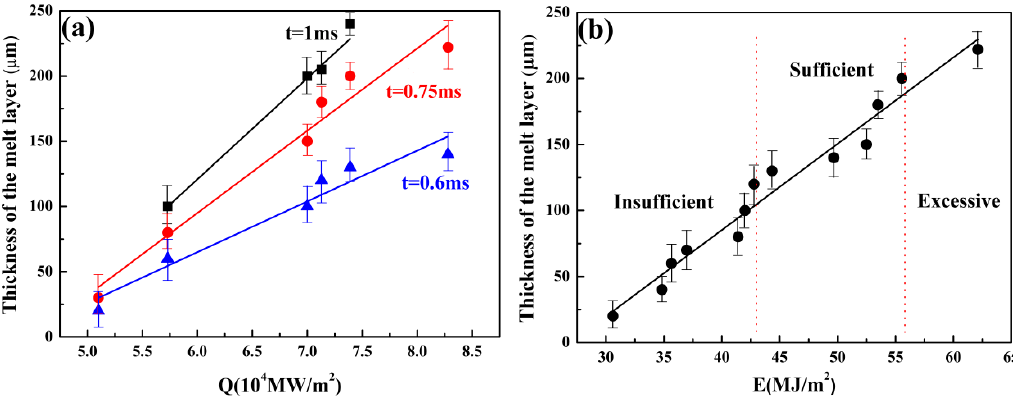
Figure 7. ( a ) The influence of laser power density and ( b ) laser energy density on the thickness of the melt layer of Cu-50Cr alloy.